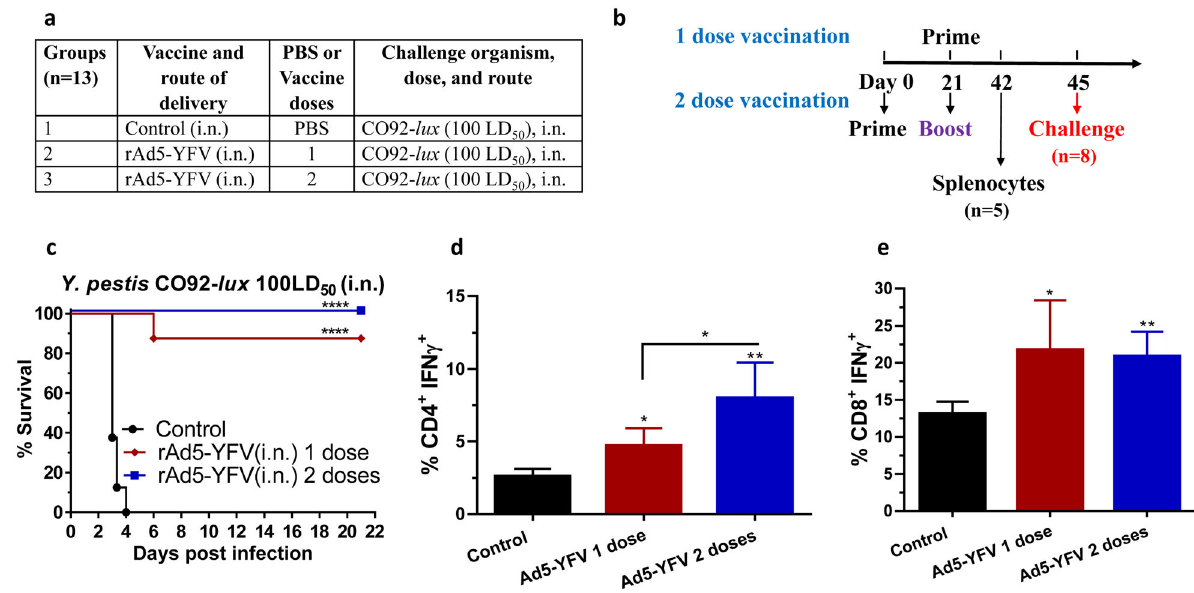
Fig. 1 Protection and immune responses in mice immunized with 1 or 2 doses of the rAd5-YFV vaccine. Female Swiss – webster mice ( n = 13/group) were immunized (i.n.) with either 1 or 2 doses (21 days apart) of rAd5-YFV vaccine (1.2 × 10 10 v.p.), and animals administered PBS served as controls ( a ). Vaccination scheme is depicted in panel b . Twenty-four days after the fi nal vaccination, eight mice from each group were i.n. challenged with 100 LD 50 (5 × 10 4 CFU/40 µL) of Y. pestis CO92- lux , and the survival of animals plotted ( c ). P values were calculated using Kaplan – Meier analysis with log-rank (Mantel – Cox) test for animal survival. Spleens were harvested from the fi ve remaining unchallenged mice in each group and splenocytes stimulated with PMA and Ionomycin. Brefeldin A was added to prevent secretion of cytokines. Splenocytes were then stained for T-cell surface markers CD3, CD4, and CD8, followed by intracellular IFN γ staining. Percent of CD4 + IFN γ + ( d ) and CD8 + IFN γ + ( e ) T cells were analyzed by fl ow cytometry and the data expressed as the arithmetic means ± standard deviations. P values were calculated using a one-way ANOVA with Tukey post-hoc test to compare multiple groups or student t -test to compare 1 dose of rAd5-YFV vaccine to control in panel e . Asterisks above columns represent comparison to the control group, while horizontal bars represent differences between test groups. * P < 0.05, ** P < 0.01, **** P < 0.0001. Two biological replicates were performed, and data